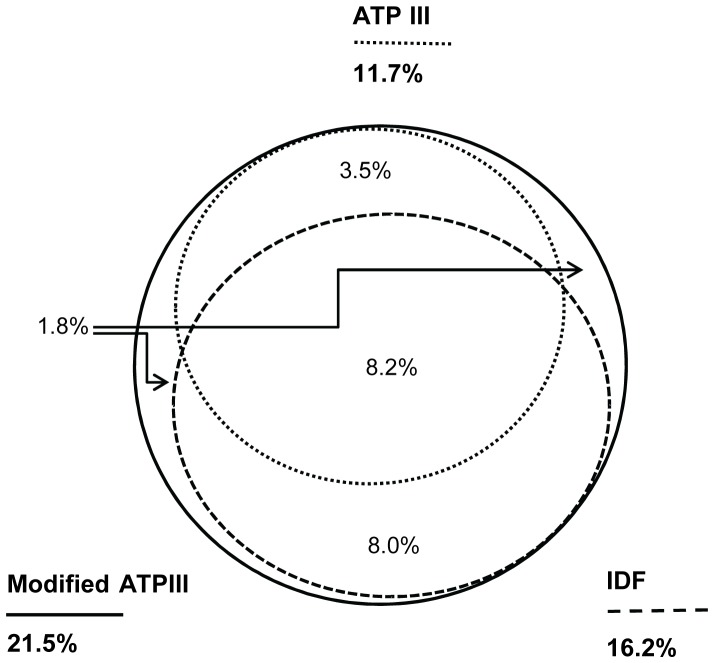
Overall crude prevalence of MetS according to ATP III, IDF and modified ATP III criteria.